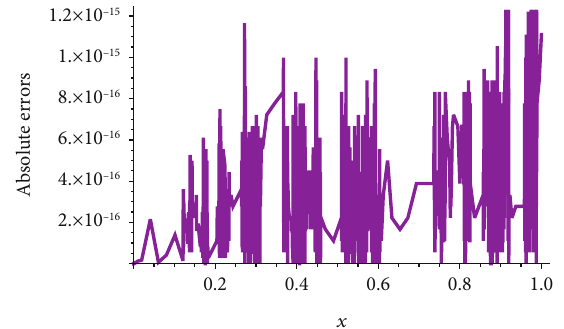
2 obtained by the present method for